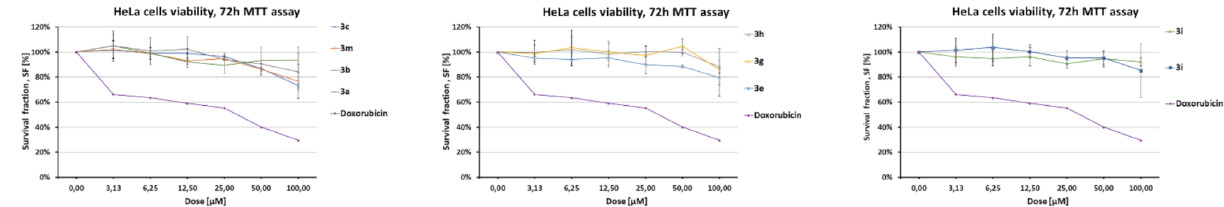
Figure 4. SF of HeLa cells after 72 h of incubation with different doses of tested compounds (0–100 µ M) and doxorubicin as a positive control. The results were presented as the mean values from 3 experiments ± SD.